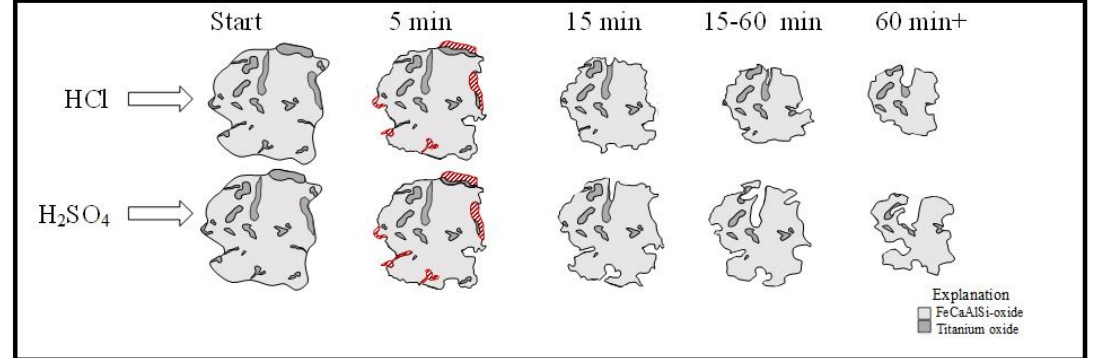
Figure 8. Dissolution model of particles by hydrochloric acid and sulfuric acid leaching.